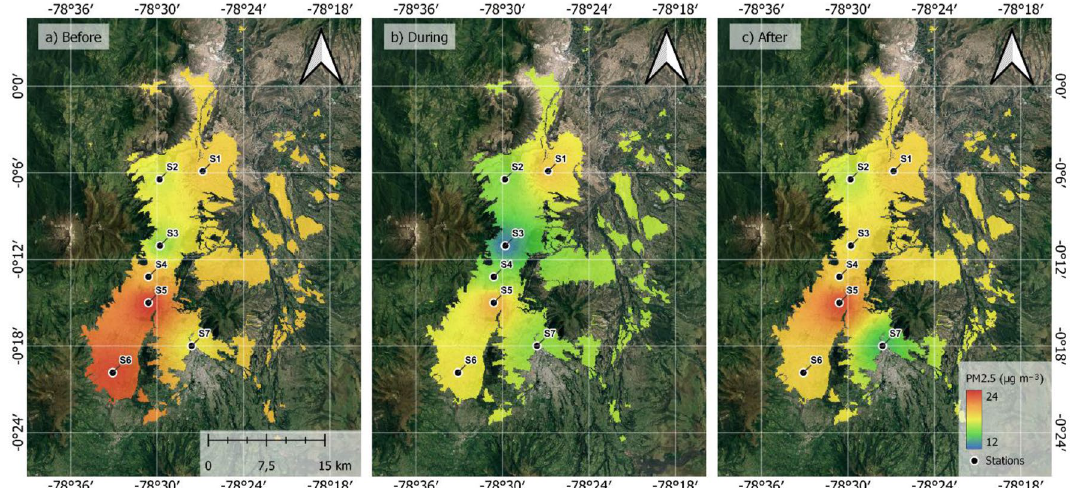
Figure 2. Inverse distance weighting interpolation of the average PM 2.5 levels at the ground-based monitoring sites in the Ecuadorian capital Quito: ( a ) before (September 25–October 1), ( b ) during (October 2–13) and ( c ) after (October 14–25) the 2019 national strike. Geographical Information Software QGIS 3.18.2 was used ( available at https:// qgis. org/ downl oads/), employing ESPG 4326 (WGS 84) (panels a – c ) and Urban Growth of Quito was used for limits (retrieved from http:// gobie rnoab ierto. quito. gob. ec/? page_ id= 1122).